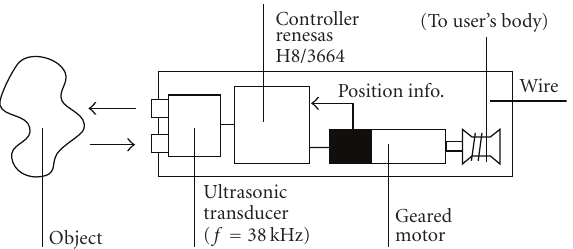
Figure 5: Mechanical architecture of the second prototype of CyARM.